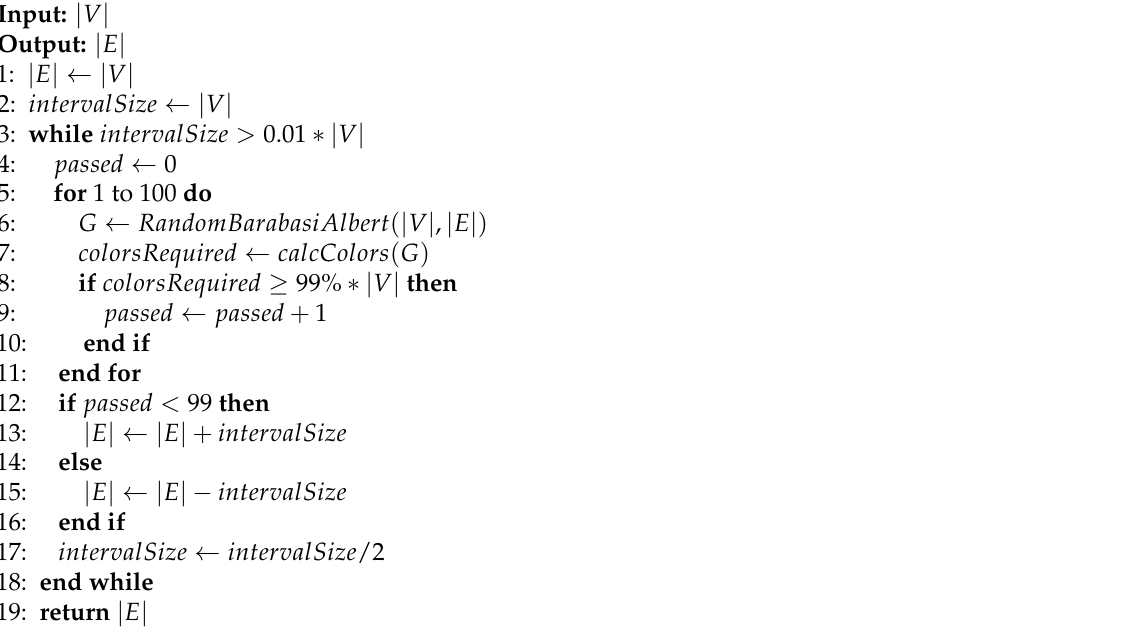
Algorithm 2 Relation between | V | & | E | to have many colors